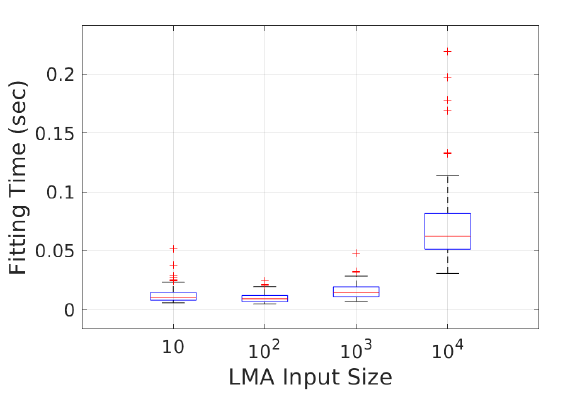
Figure 16. Robustness of SPPE to LMA input